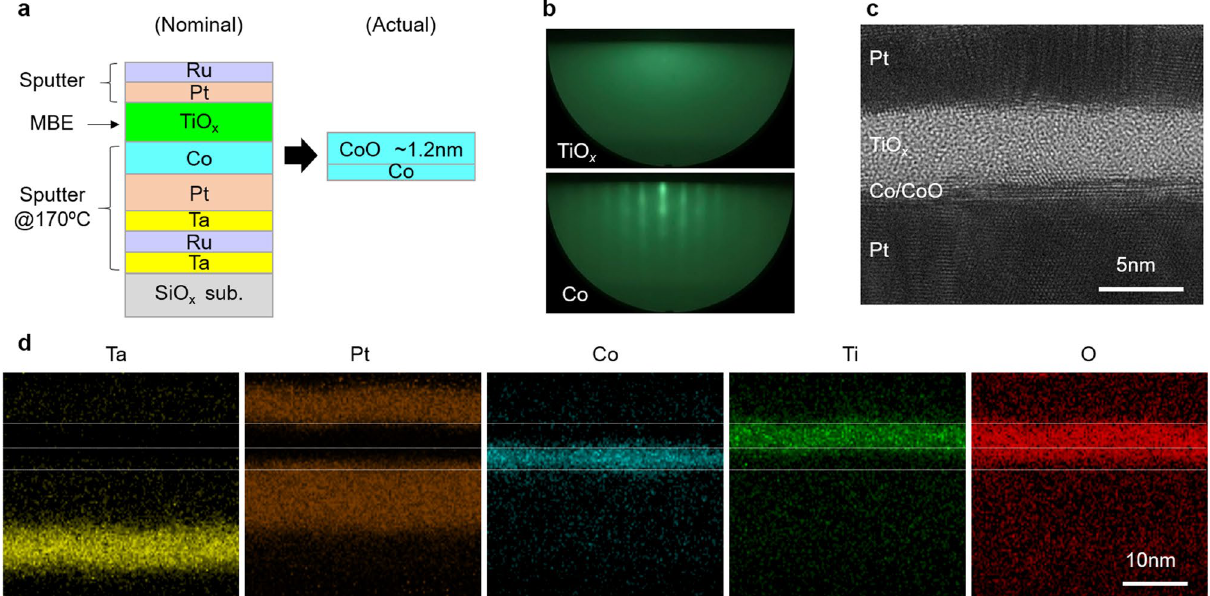
Figure 1. ( a ) Schematics of the nominal and estimated actual film structures, ( b ) RHEED patterns of Co (lower image) and TiO x (upper image) layers, ( c ) cross sectional TEM image, and ( d ) EDX element maps (Ta, Pt, Co, Ti, and O) of nominal SiO x sub./Ta (5 nm)/Ru (10 nm)/Ta (5 nm)/Pt (10 nm)/Co (1.2 nm)/TiO x (3.8 nm)/Pt (5 nm)/Ru (2 nm) sample. The dotted white lines are visual guidelines indicating the approximate Ti and Co layer